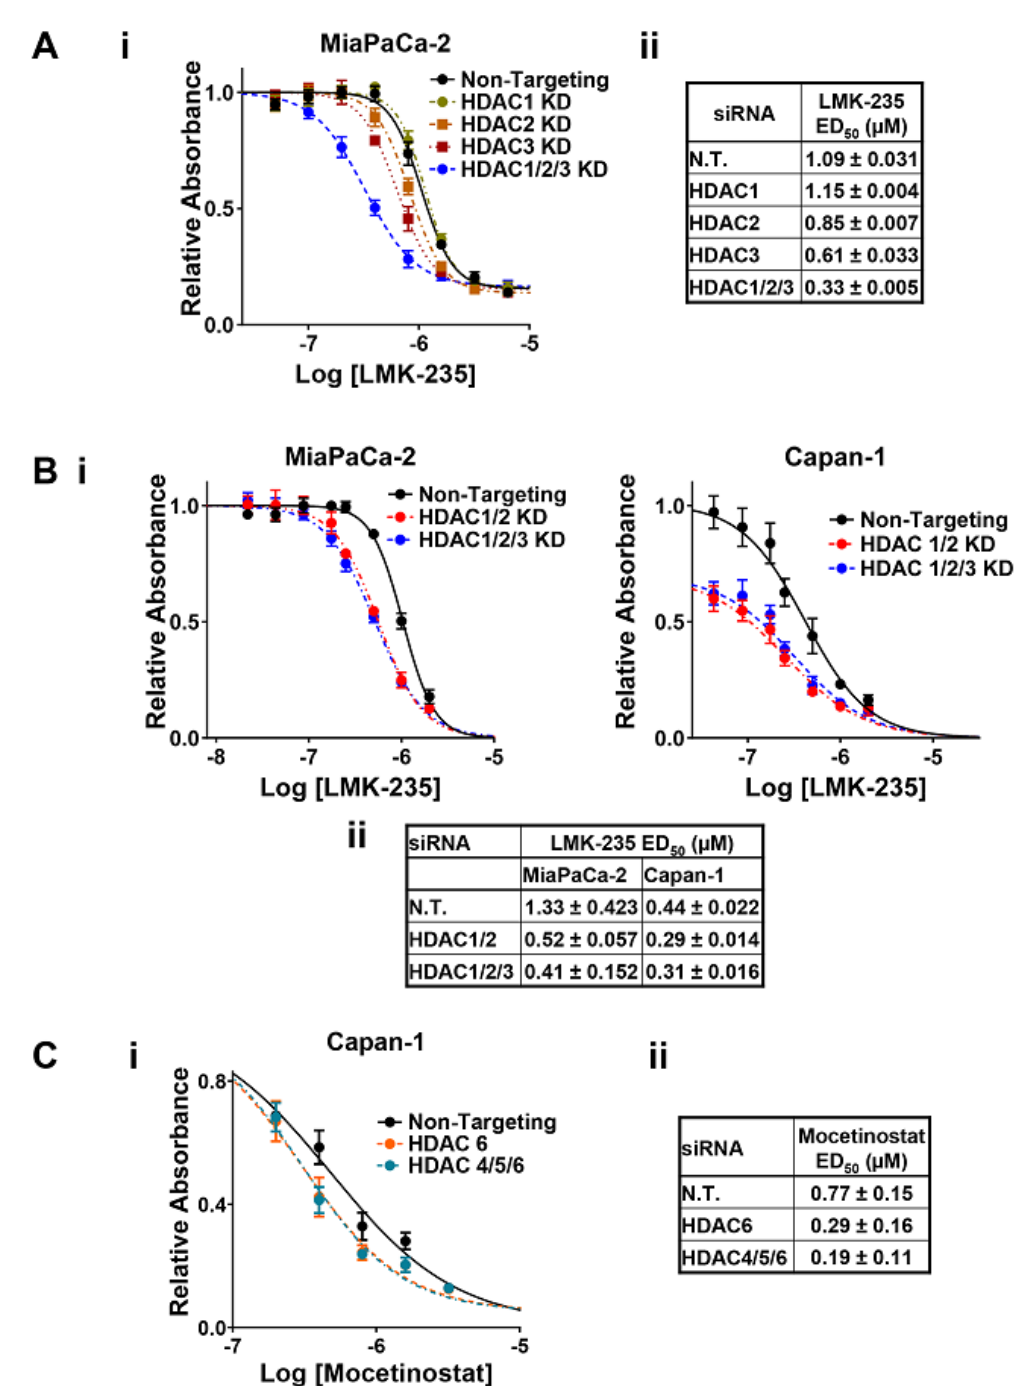
Figure 3. HDACs 1, 2, and 6 account for the synergism between Mocetinostat and LMK-235 in PDAC cells. HDACs 1, 2, and 3 ( A , B ) or HDACs 4, 5, and 6 ( C ) were knocked down (KD) in MiaPaCa-2 and / or Capan-1 cells by transfection with ONTARGET plus SMARTPool siRNAs targeting specific HDACs either individually or in combination, as indicated. Control cells were treated with non-targeting (N.T.) siRNA and, 24 h after transfection, cells were treated with various concentrations of LMK-235 ( A , B ) or Mocetinostat ( C ) and subjected to MTT assay after 72 h of drug treatment. ( i ) Representative graph of the e ff ect of various concentrations of LMK-235 or Mocetinostat on the relative number of viable cells (absorption at 570 nm) following knockdown of the indicated HDACs (mean ± s.d. of six technical replicates for each condition). ( ii ) ED 50 values for LMK-235 ( A , B ) or Mocetinostat ( C ) in cells transfected with the indicated siRNAs (mean ± s.d. for three biological replicates).